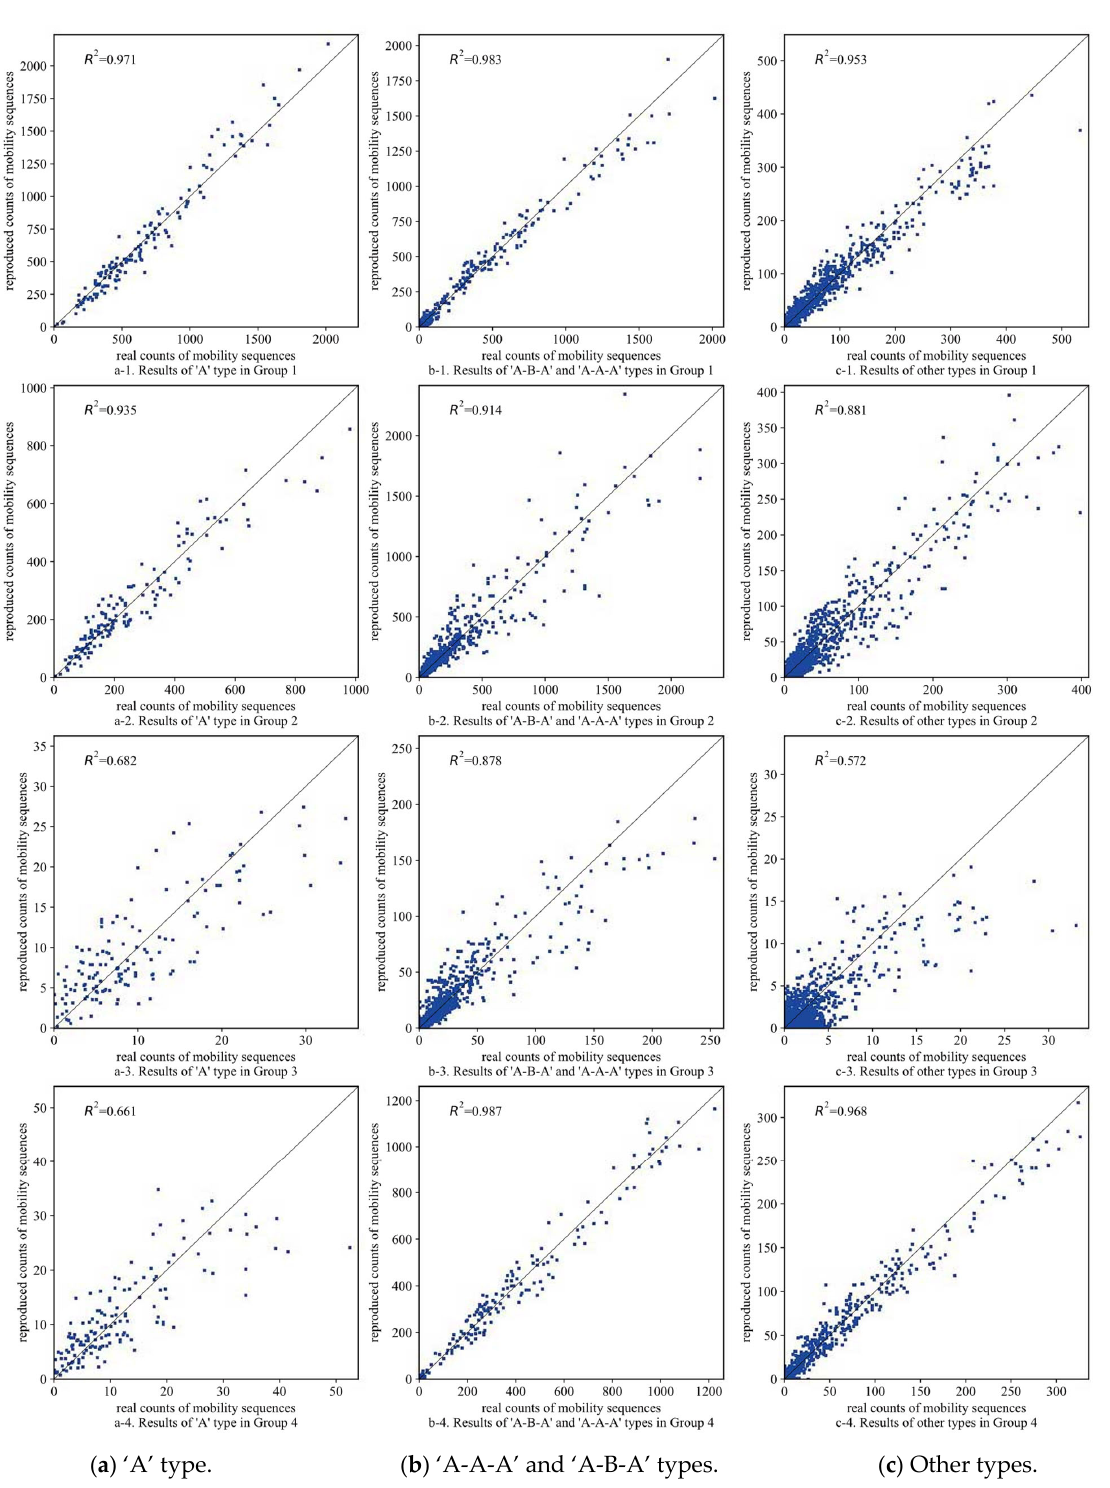
Figure A1. Spatial evaluation for the reproduction results for 1998. ( a ) Results for ‘A’ type; ( b ) Results for ‘A ‐ A ‐ A’ and ‘A ‐ B ‐ A’ types; ( c ) Results for other types.